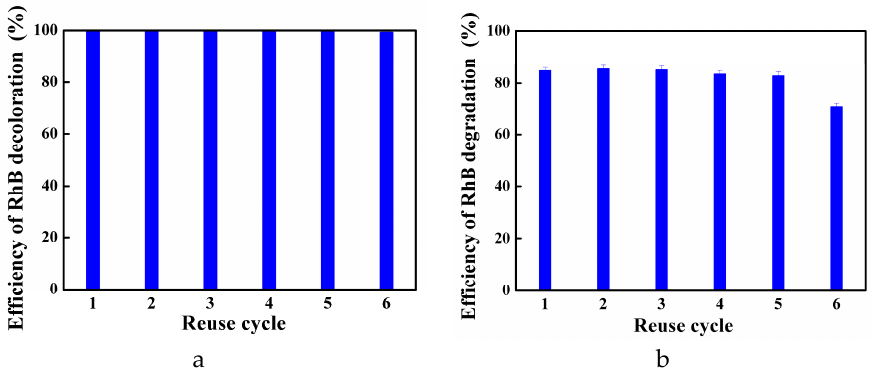
a b Figure 7. Consecutive use of MnO 2 @m ‐ SiO 2 for RhB decoloration ( a ) and degradation ( b ). The Figure 7. Consecutive use of MnO 2 @m-SiO 2 for RhB decoloration ( a ) and degradation ( b ). immersion time of MnO 2 @m ‐ SiO 2 in the solution of RhB was 60 min for each cycle. The immersion time of MnO 2 @m-SiO 2 in the solution of RhB was 60 min for each